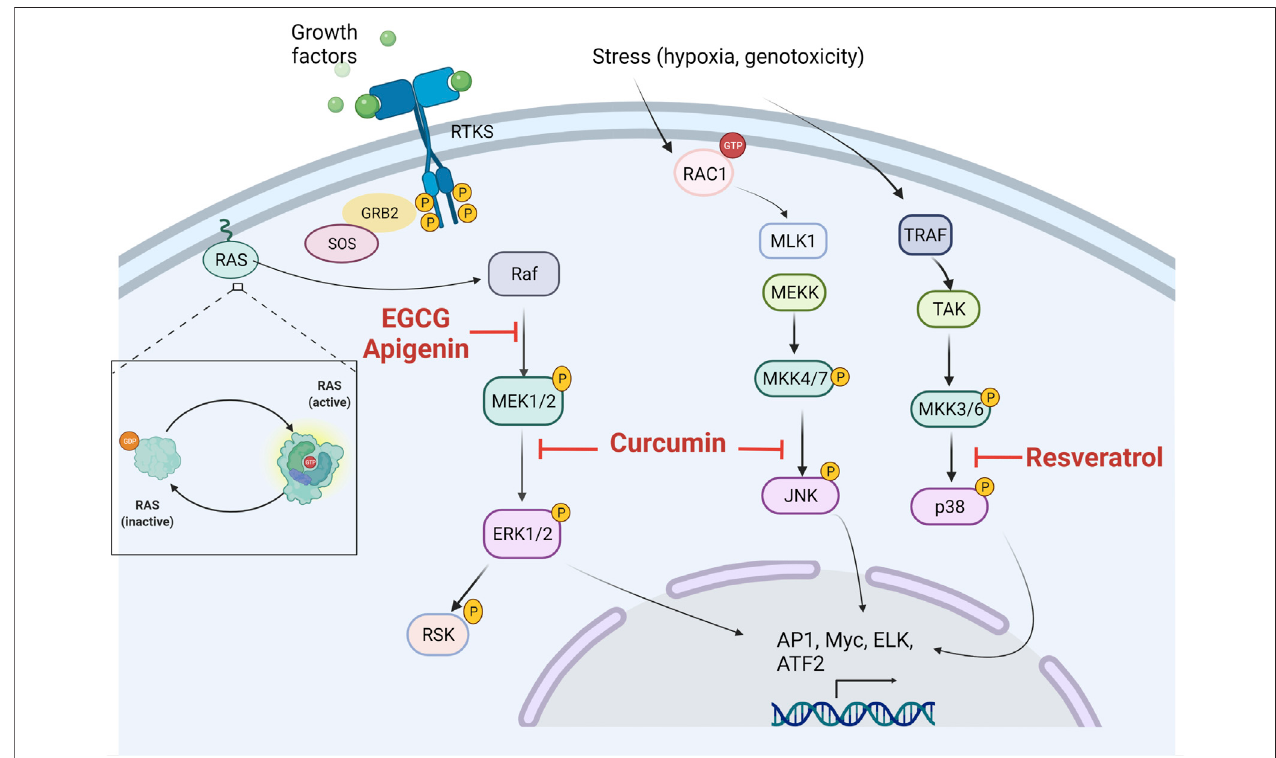
FIGURE 3 | Potential sites of inhibitory actions of polyphenols in MAPK signaling pathways. ERK, extracellular signal-related kinases; JNK, c-Jun amino-terminal kinases; p38, p38 mitogen-activated protein